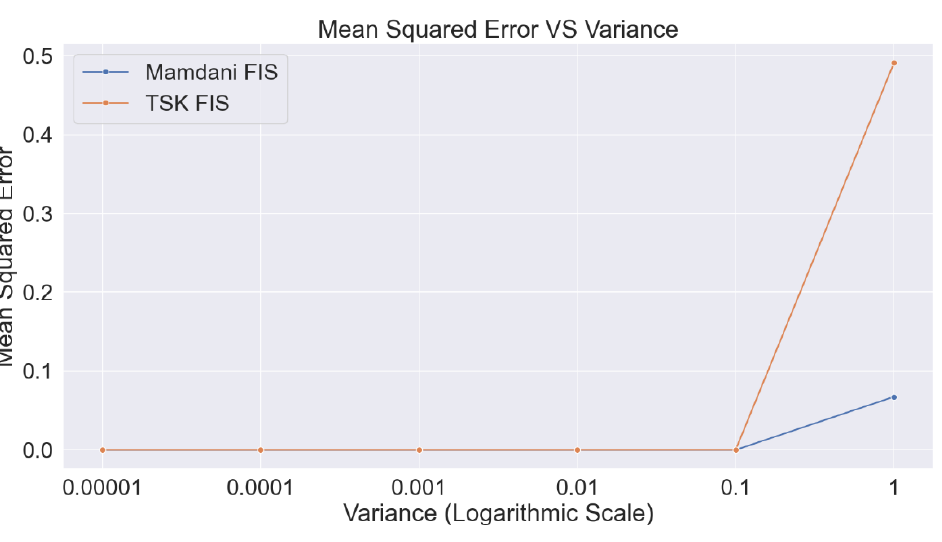
Table 7. Mamdani vs. TSK agent Algorithm 4: XAI Agent Benchmark using a given XAI core